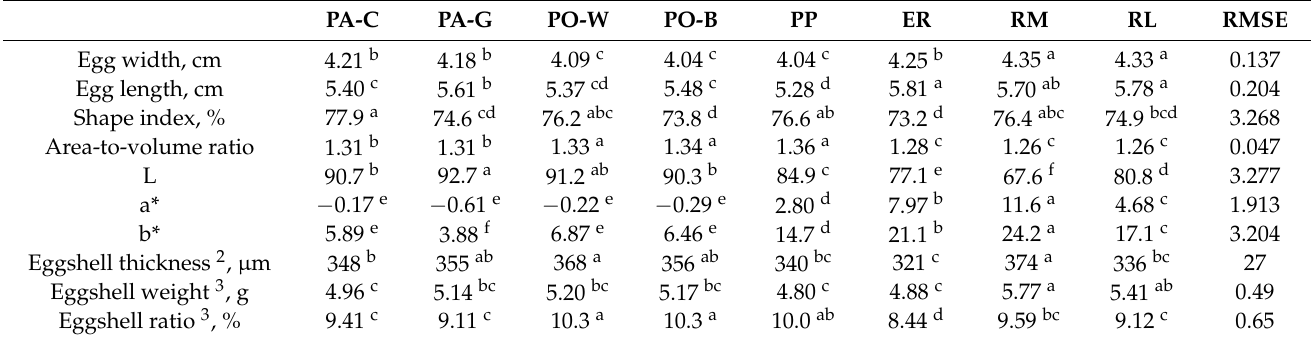
Table 2. Least squares means of eggshell traits of the breeds.